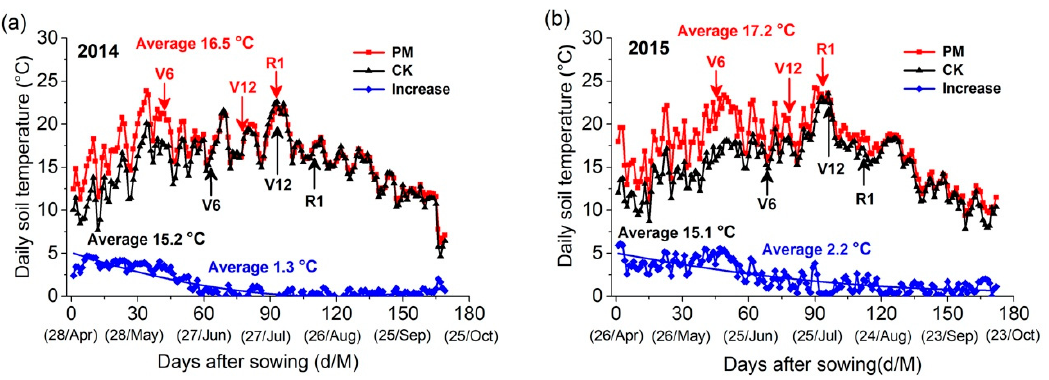
Figure 3. Daily soil temperature in mulched (PM) and check (CK) plots and the difference in soil temperature between the PM and CK plot in the ( a ) 2014 and ( b ) 2015 growing seasons. V6: six-leaf stage, V12: twelve-leaf stage, and R1: silking stage.